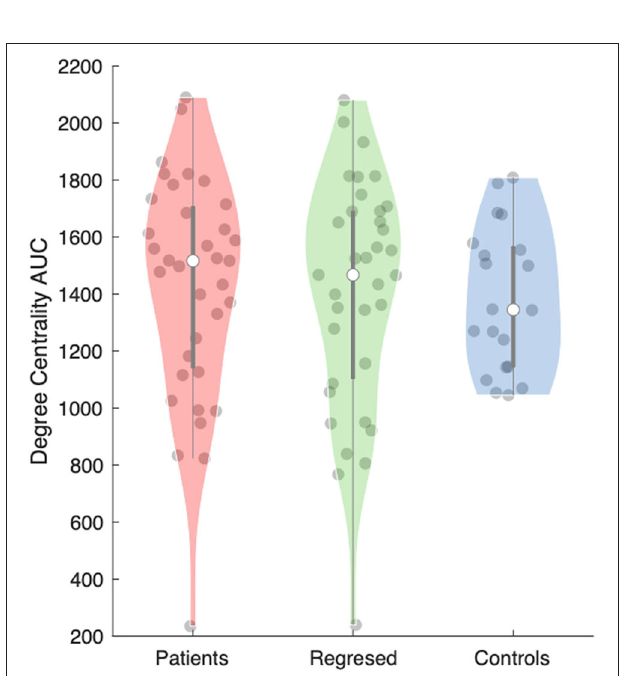
FIGURE 3 | Area under the curve (AUC) for the degree centrality of the anterior thalamic subregion ipsilateral to the epileptogenic zone (EZ). The violin plot (28) demonstrates the distributions of the AUC for degree centrality in patients before (red) and after (green) interictal epileptiform discharges (IEDs) and controls (blue). The clear dot shows the